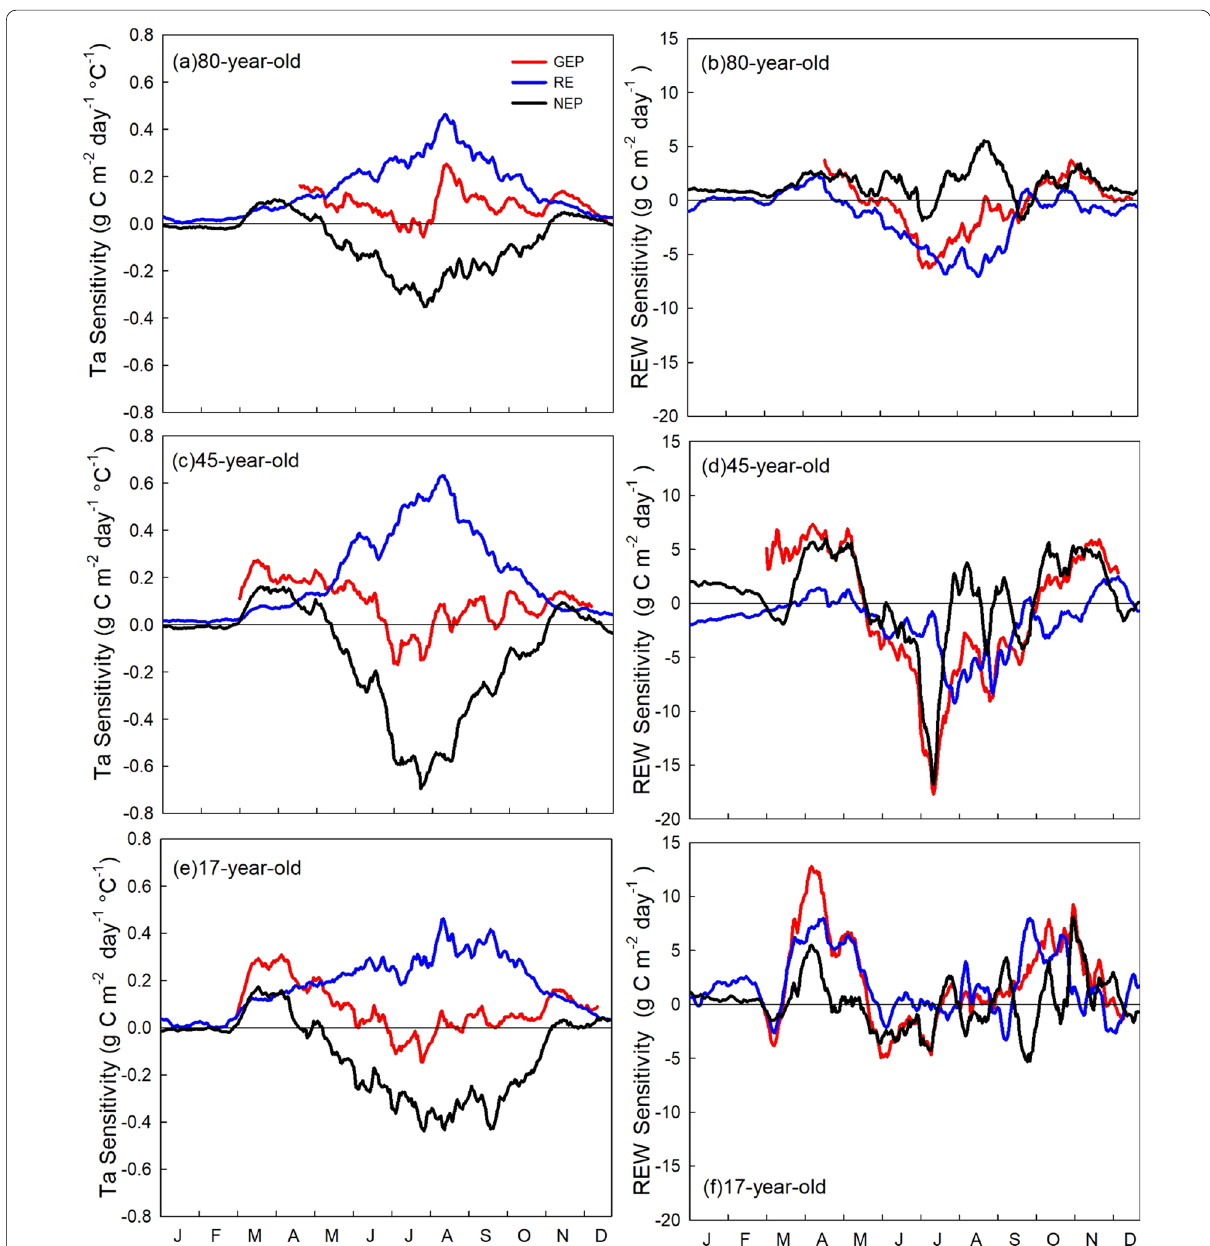
Fig. 6 Daily sensitivities of carbon fluxes to air temperature (Ta) and dryness represented by relative extractable water (REW) anomalies. Curves show the mean sensitivity in the 15 day moving windows. Data were detrended and normalized to remove forest growth and long‑term climate variability impacts. When the flux vs climate variable correlation for 15 day moving averages was significant ( p < 0.05), the slope of the regression showed the effect of climate constraints on the carbon fluxes (following Schwalm et al. 2010; Wu and Chen